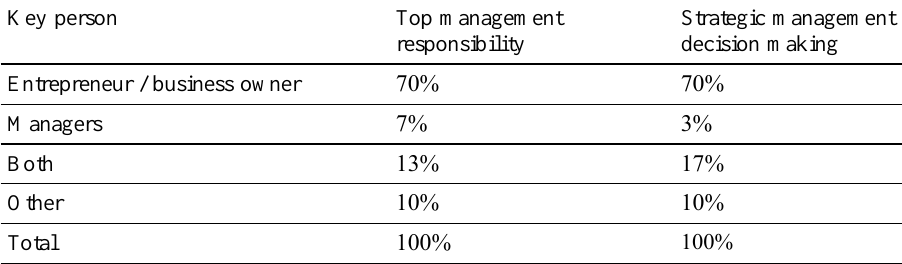
Table 7. Top management responsibility and strategic management decision making Key person